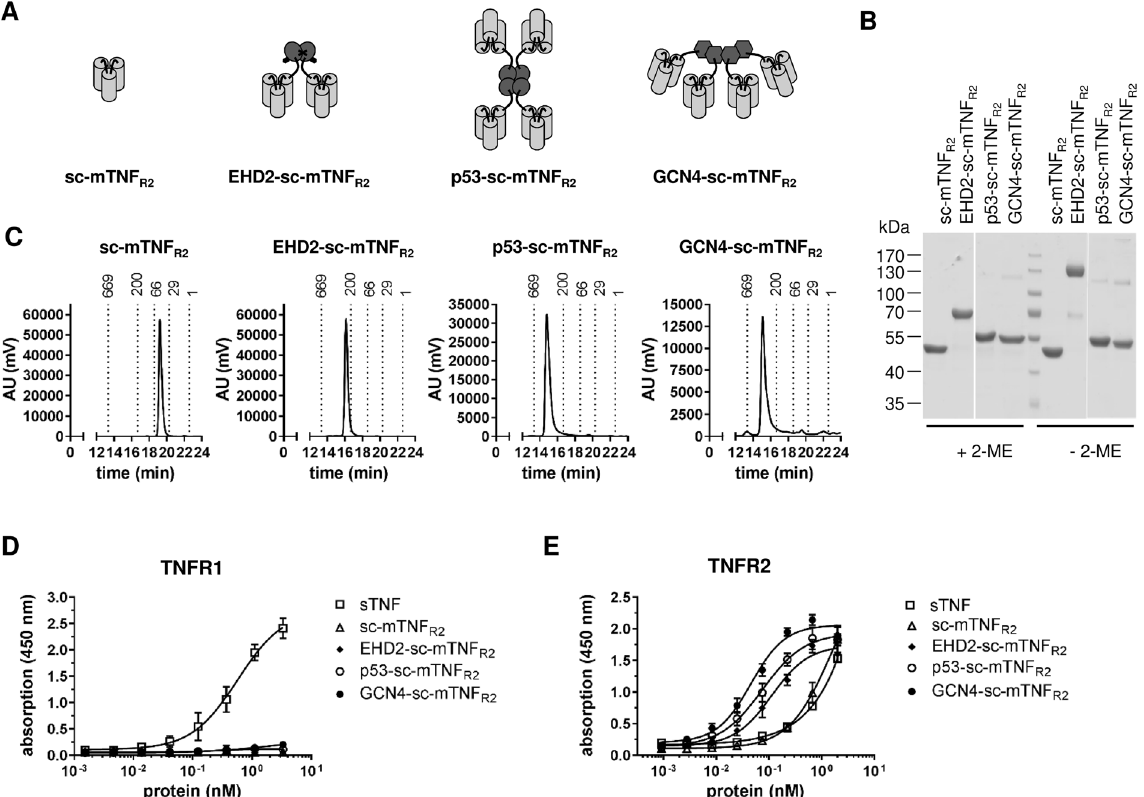
Figure 1. Characterization of oligomeric TNFR2 selective TNF muteins ( A ) Schematic representation and size exclusion chromatography analysis of the differently oligomerized TNF muteins sc-mTNF R2 , EHD2-sc- mTNF R2 , p53-sc-mTNF R2 and GCN4-sc-mTNF R2 . ( B ) Coomassie staining of sc-mTNF R2 , EHD2-sc-mTNF R2 , p53-sc-mTNF R2 and GCN4-sc-mTNF R2 . Purified TNF variants were analyzed by 8% SDS-PAGE under reducing ( + 2-ME) or non-reducing ( − 2-ME) conditions and stained with Coomassie. ( C ) Size exclusion chromatography analysis of the differently oligomerized TNF muteins sc-mTNF R2 , EHD2-sc-mTNF R2 , p53- sc-mTNF R2 and GCN4-sc-mTNF R2 . ( D , E ) Binding of the TNF muteins to mouse ( D ) TNFR1 and ( E ) TNFR2 was analyzed by ELISA. Soluble recombinant mouse TNF (sTNF) was used as a positive control for binding to TNFR1 (n = 3 ±